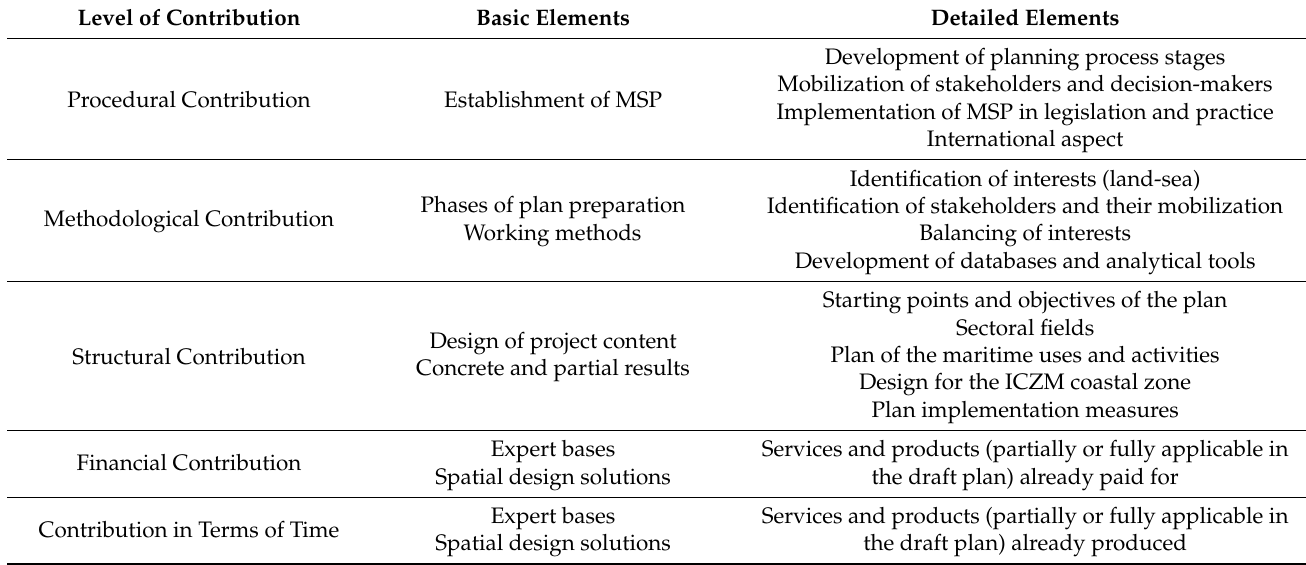
Table 14. Contribution of the projects to the development and preparation of the draft